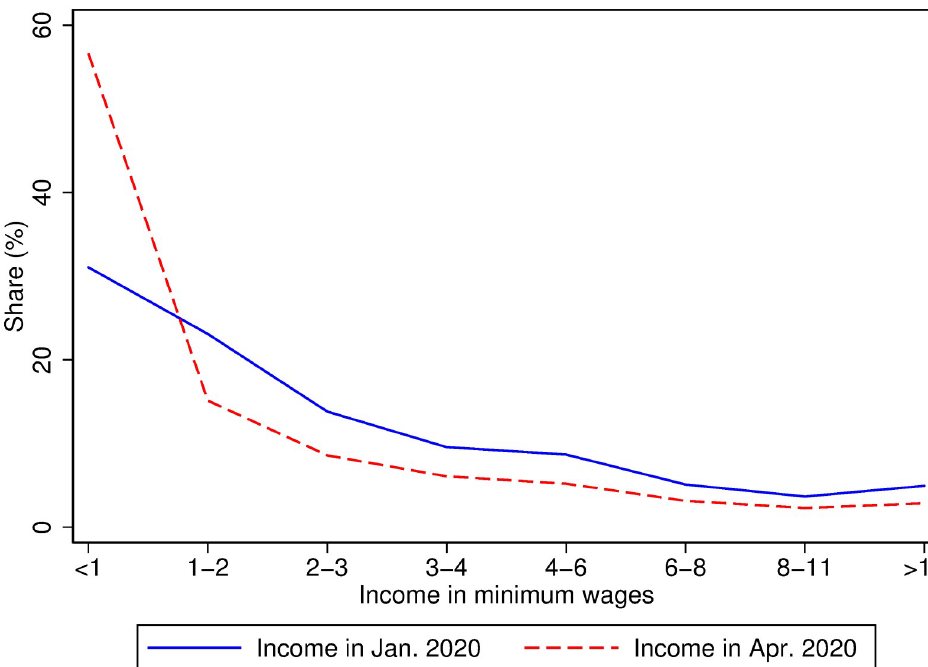
Fig 3. The share of households in the bottom part of the income distribution is expected to increase. Shares of households in each income bin for incomes reported for January 2020 and April 2020. Data counts weighted using within- and cross-country weights. See Empirical Methods in the Supplementary Information section for